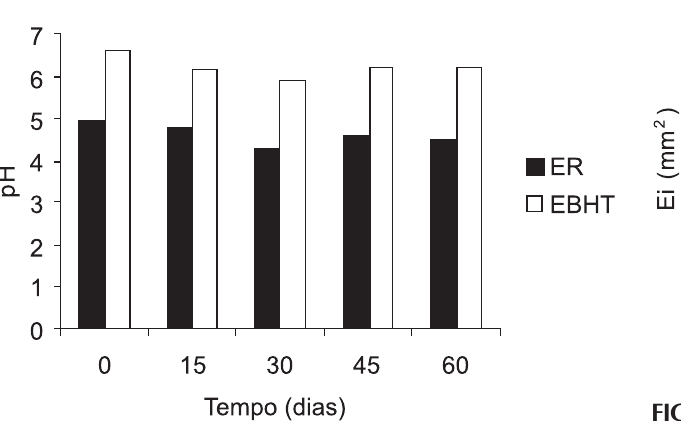
FIGURA 3 - Valores de pH da EBHT e ER armazenadas a 4° C em função do tempo de armazenamento (n=3).